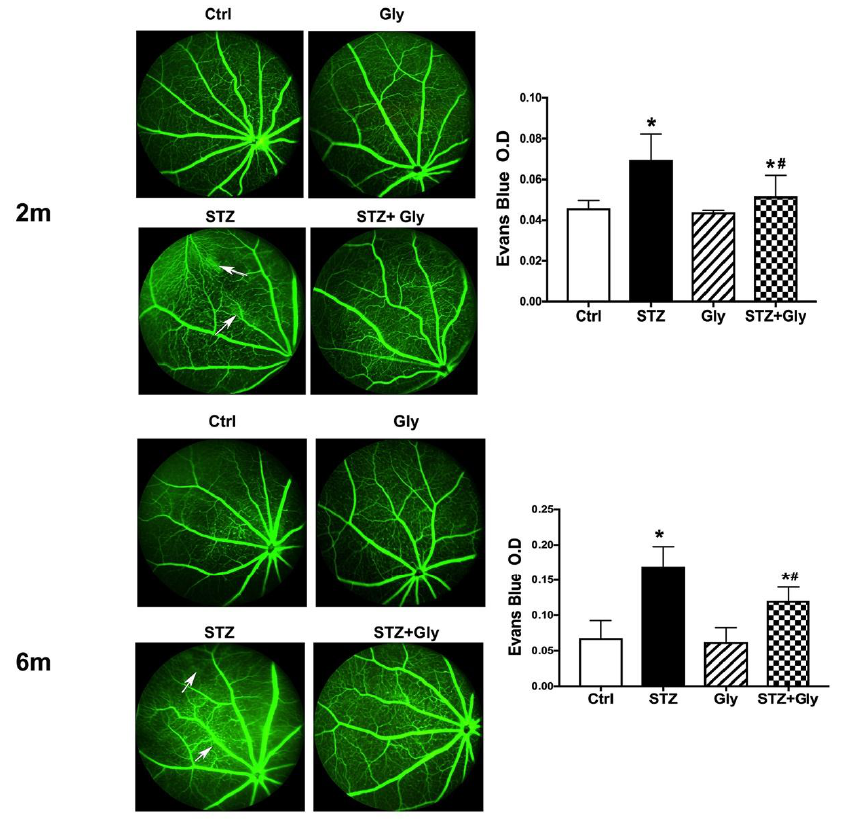
Figure 1. Fluorescein angiography (left) and Evan’s blue analyses (right) from control mice (Ctrl), control mice treated with glycyrrhizin (Gly), diabetic mice (STZ), and diabetic mice treated with glycyrrhizin (STZ + Gly) at two months (top) and six months (bottom). Arrows point to areas of leakage. * p < 0.05 vs. ctrl, # p < 0.05 vs. Diabetes. n = 5 for each group. 3.3. Neuronal Measurements Were Increased in Mice Receiving Glycyrrhizin Compared to Diabetic Only Retina at Two Months